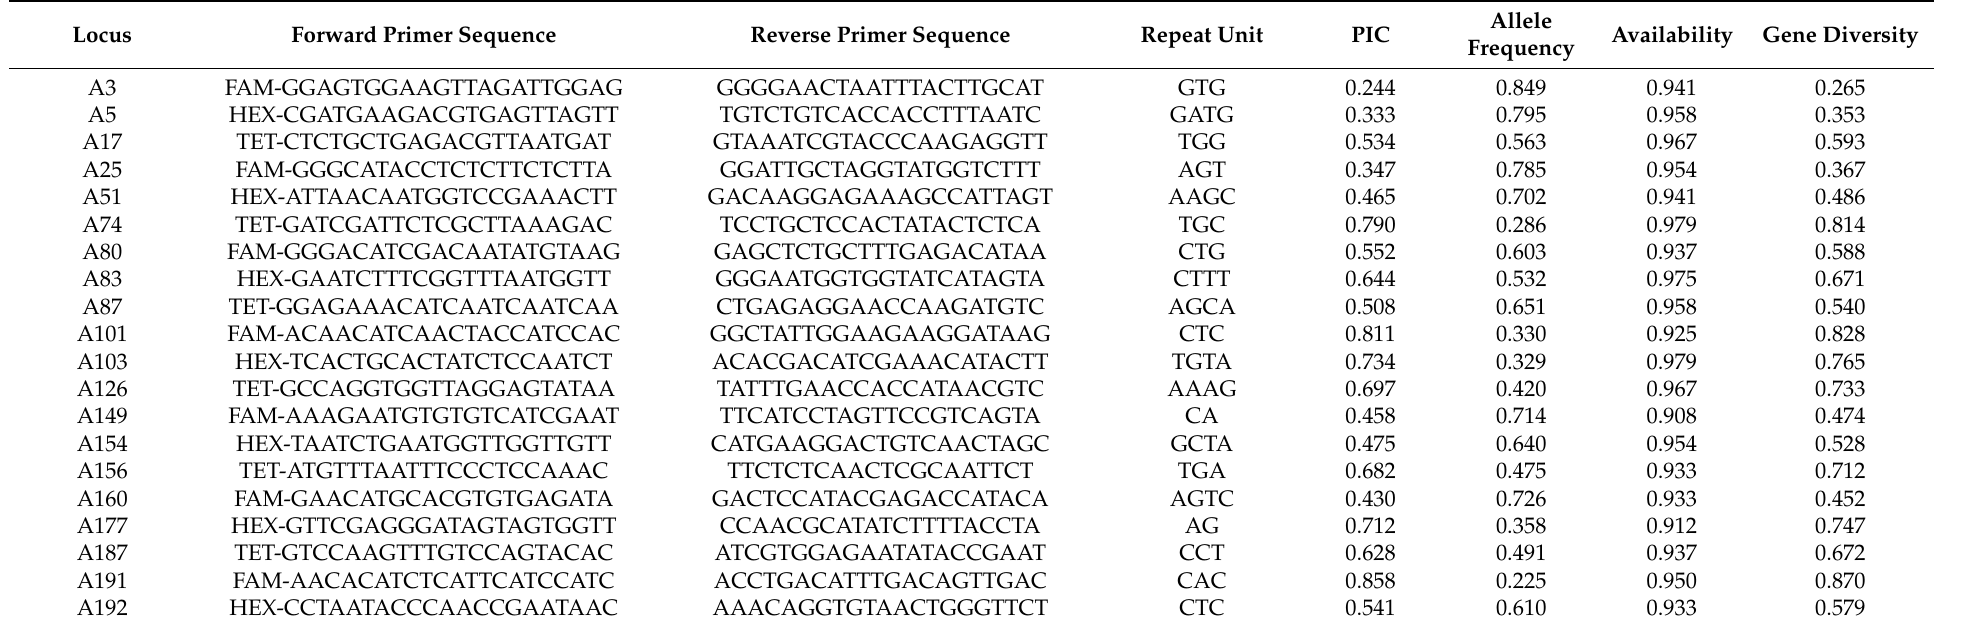
Table 2. Characterization of 20 STR loci that were newly developed in this